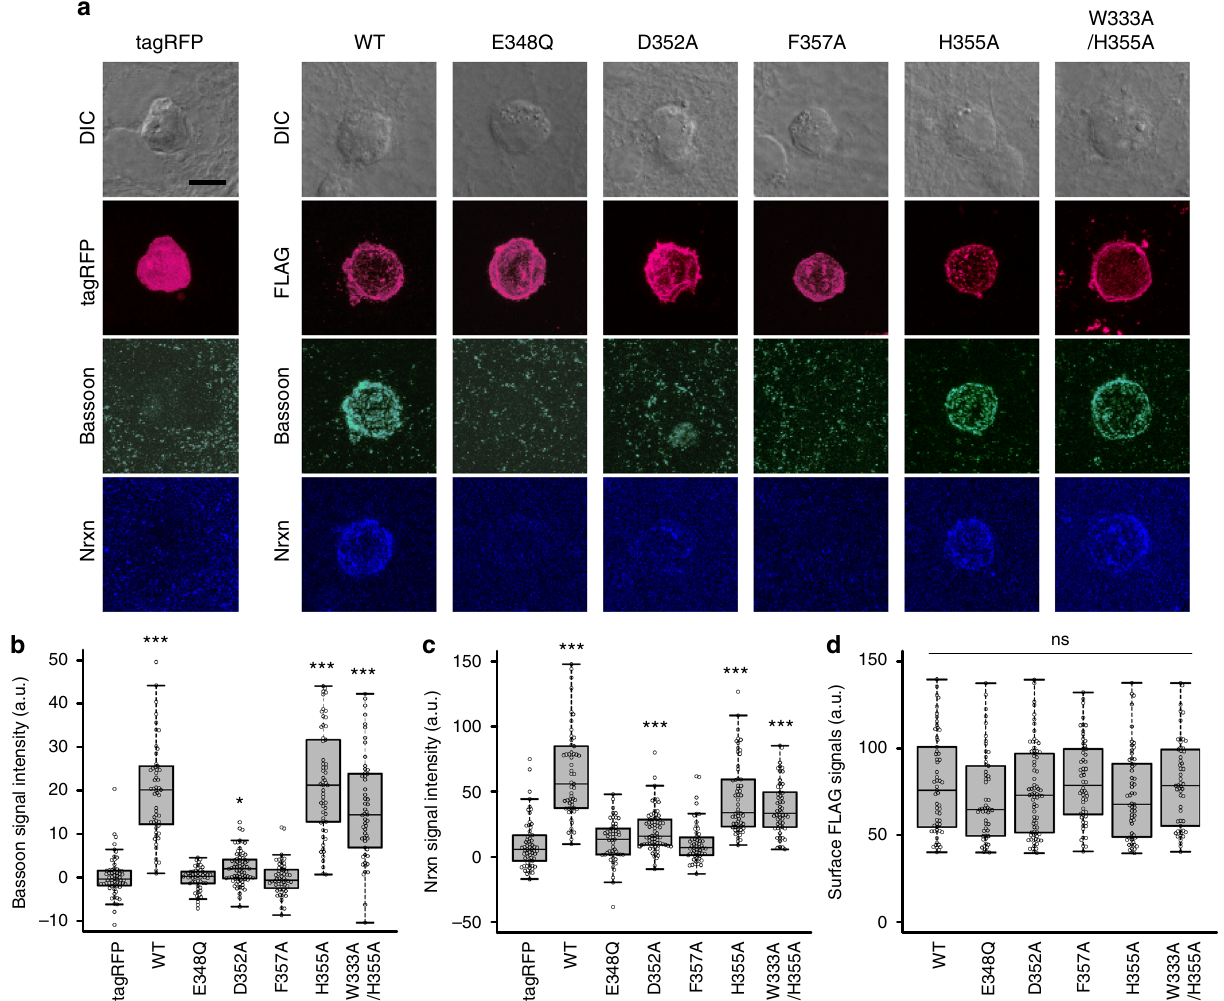
Fig. 6 Presynapse-inducing activities of human LRRTM2 mutants. a Co-cultures of cortical neurons and HEK293T cells expressing TagRFP alone or FLAG- tagged human LRRTM2 mutants. Co-cultures were immunostained with antibodies against FLAG tag (magenta), Bassoon (turquoise), and Nrxn (blue). The corresponding differential interference contrast (DIC) images are also shown on the top. Scale bar represents 10 μ m. b Staining signal intensities of Bassoon around HEK293T cells expressing FLAG-tagged LRRTM2 mutants. c Staining signal intensities of Nrxn around HEK293T cells expressing FLAG- tagged LRRTM2 mutants. d Staining signal intensities of cell surface FLAG tag on HEK293T cells expressing FLAG-tagged LRRTM2 mutants. b – d The horizontal line in each box indicates the median, the box shows the interquartile range (IQR), and the whiskers are 1.5 × IQR. Statistical signi fi cance was evaluated by the Kruskal – Wallis test followed by post-hoc Steel ’ test. *** p < 0.001 and * p < 0.01, compared with TagRFP; n = 62 (tagRFP), 57 (WT), 53 (E348Q), 74 (D352A), 56 (F357A), 57 (H355A), and 54 (W333A/H355A)